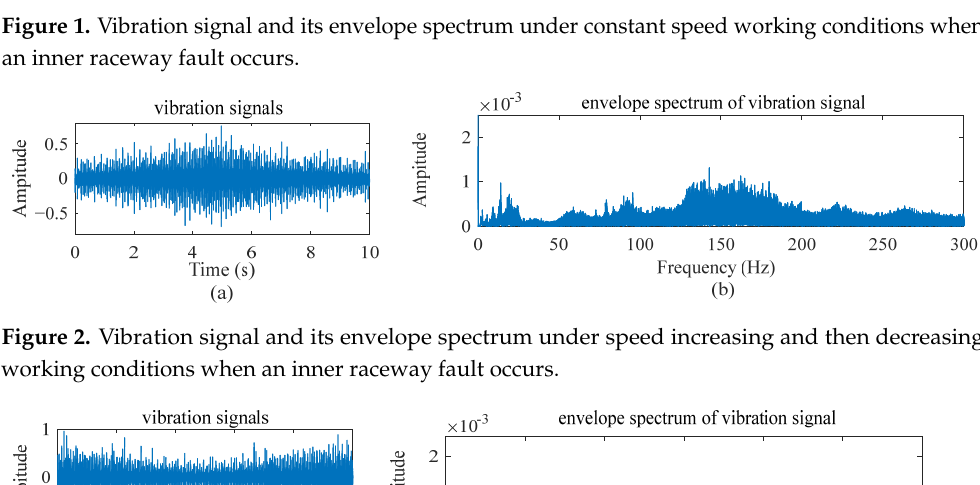
containing important fault